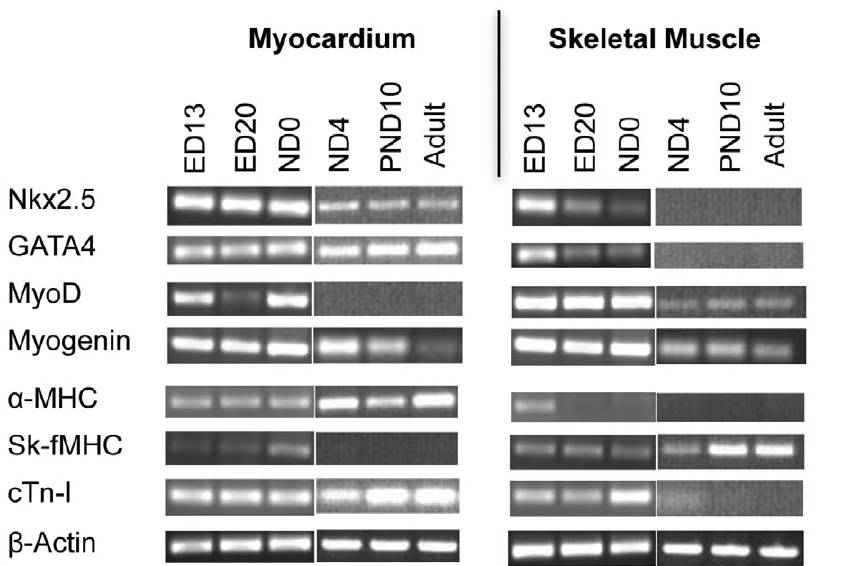
Figure 4. RT-PCR analysis of cardiac and skeletal muscle transcription factors, sk-fMHC, cTn-I mRNA expression. Lane 1 : ED13 ventricle, Lane 2 : ED20 ventricle; Lane 3 : ND0 ventricle; Lane 4 : ND4 ventricle; Lane 5 : PND10 ventricle; Lane 6 : Adult ventricle; Lane 7 : ED13 hind limbs; Lane 8 : ED20 hind limbs, Lane 9 : ND0 hind limbs; Lane 10 : ND4 hind-limbs; Lane 11 : PND10 gastrocnemius muscle; Lane 12 : Adult gastrocnemius muscle. We note that ED20 skeletal muscle (hind limbs) mRNA expression patterns are similar to ED20 ventricular myocardium.